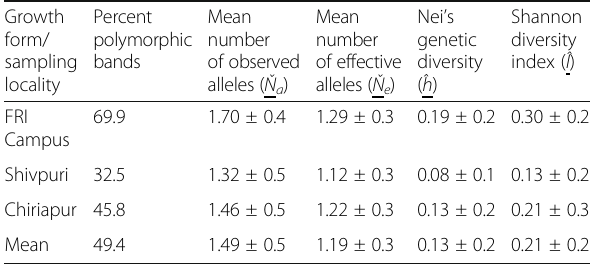
Table 5 Genetic variability statistics for the members of the three growth forms of D. strictus